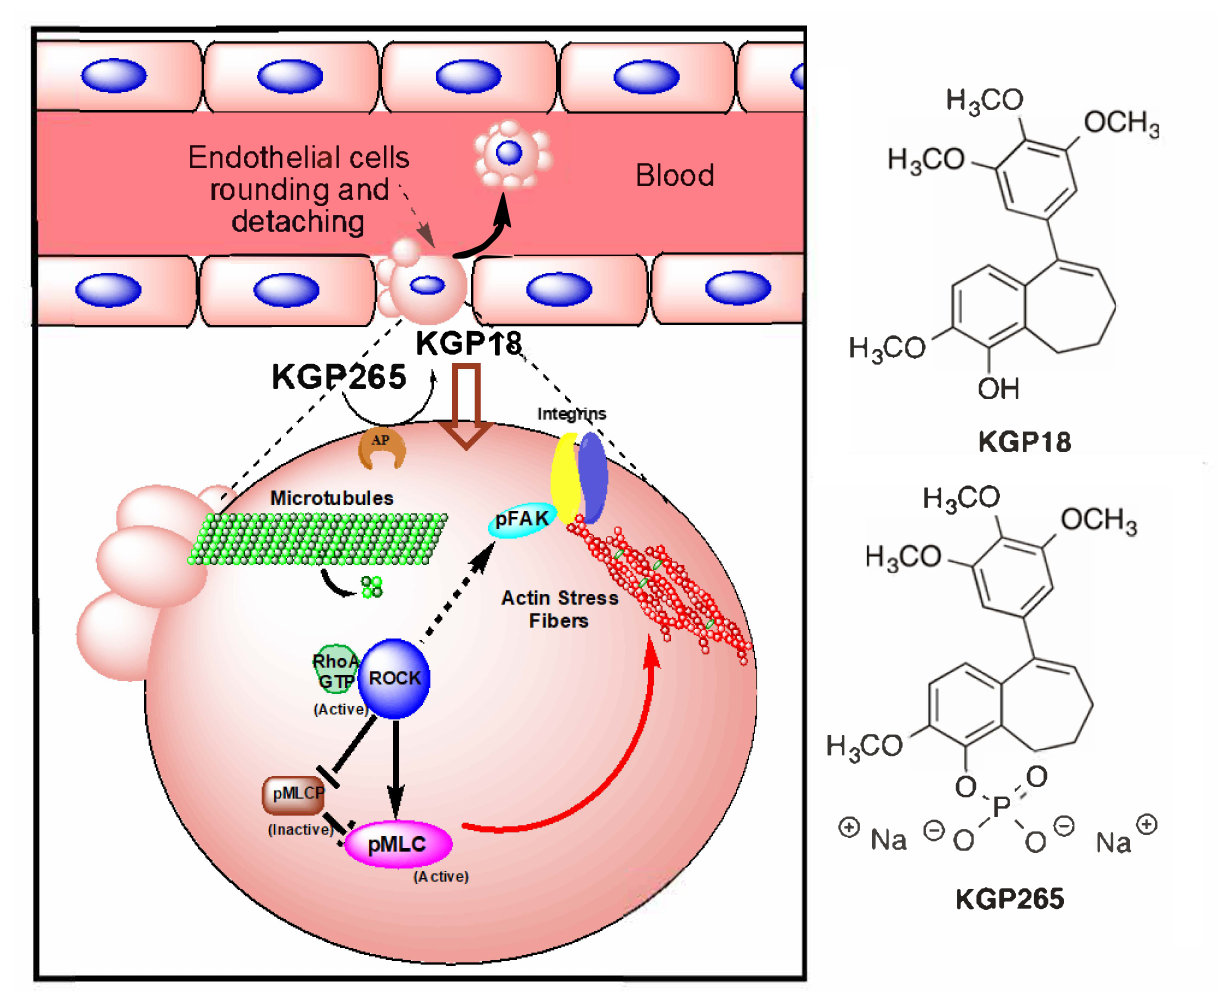
Figure 1. Proposed KGP265 mechanism in the tumor vasculature Rapid dephosphorylation of the prodrug KGP265 in the tumor vessel endothelium yields the active agent KGP18, which binds to tubulin, inhibits tubulin polymerization and leads to the activation of RhoA kinase (ROCK). The Phosphorylation of the downstream ROCK targets results in the formation of actin stress fibers. As actin stress fibers resolve, endothelial cells become round, form blebs and detach, culminating in vascular disruption. See Figure 2 and Supplementary Figures S1 and